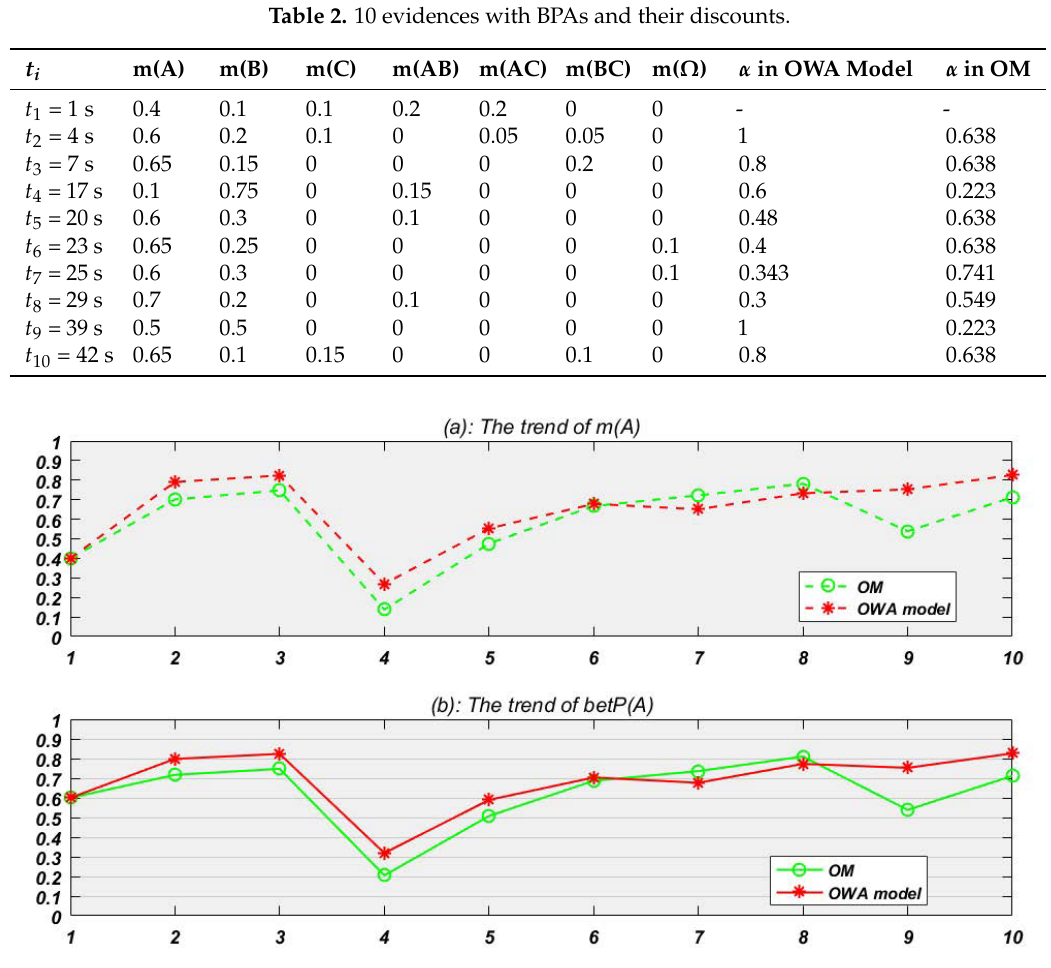
Figure 3. Results of Example